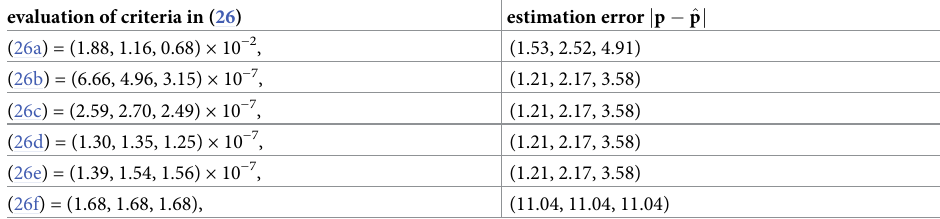
Table 2. Evaluations of least squares criteria and estimation errors over 50 simulation runs with averaged values in a bracket corresponding to cases 1, 2 and 3 of measurement availability. evaluation of criteria in